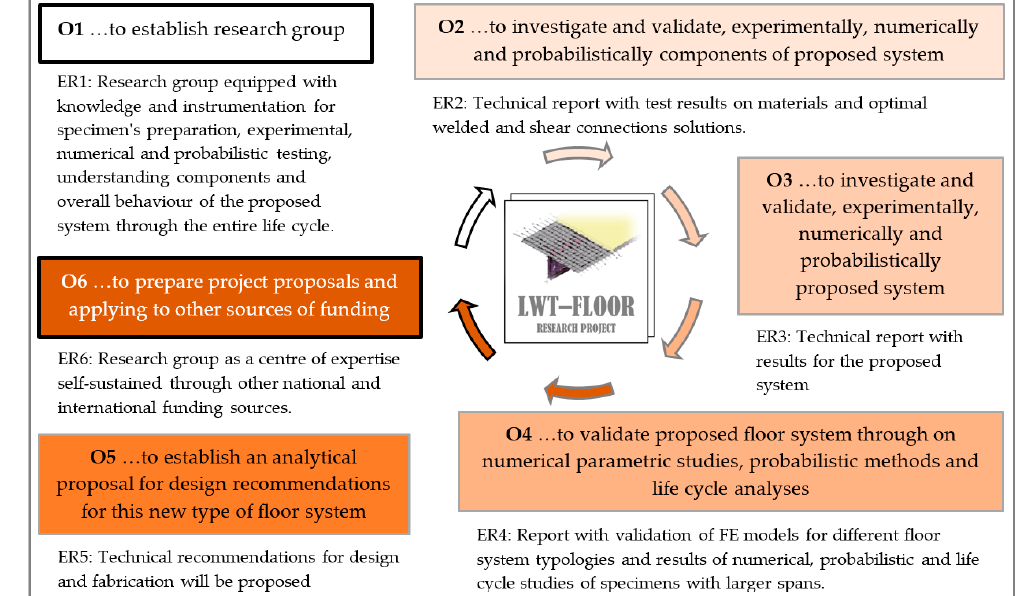
Figure 5. Technical and scientific objectives of the LWT-FLOOR project.